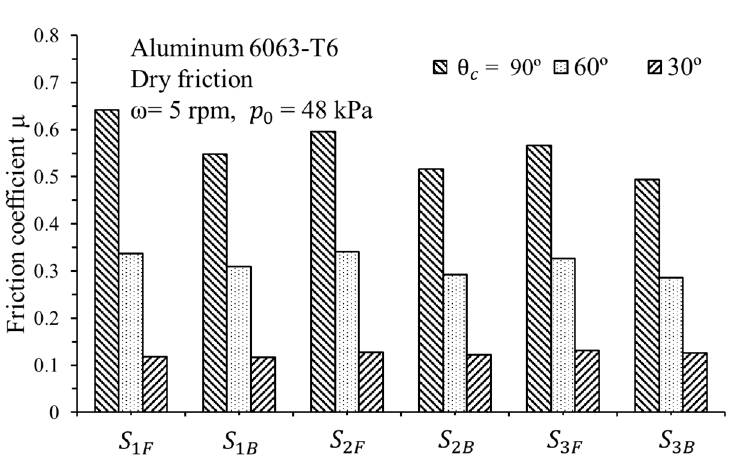
Figure 14. Friction coefficient variations with different contact angles for Al6063-T6. Table 3. Average friction coefficients µ under dry friction, values in square brackets denote µ under lubricated conditions.